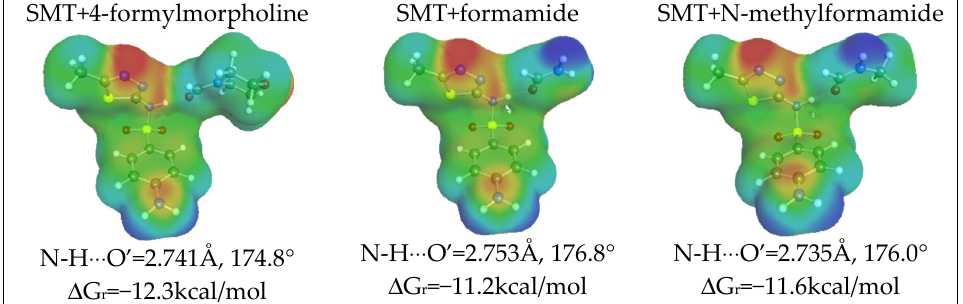
Figure 11. Schematic representation of structure and charge densities of the most stable pairs involving sulfamethizole in the studied systems. The notations are the same as those in Figure 4.